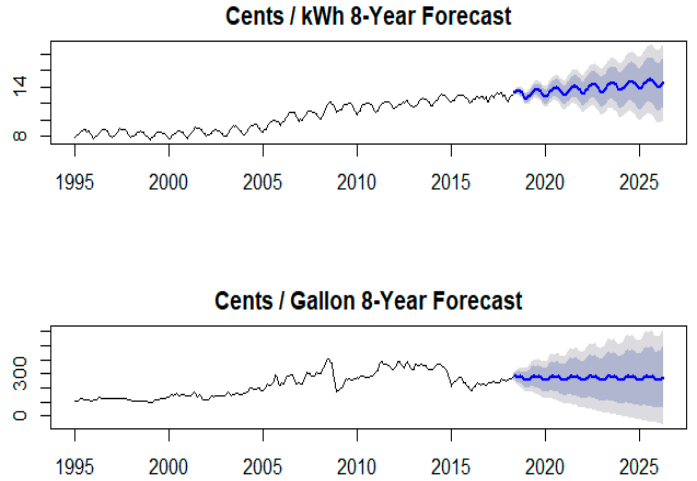
Figure 5. Forecasts for cents/kWh and cents/gallon of gasoline for the best error/trend seasonality (ETS) models are shown. The large forecast period results in error bands being wide.